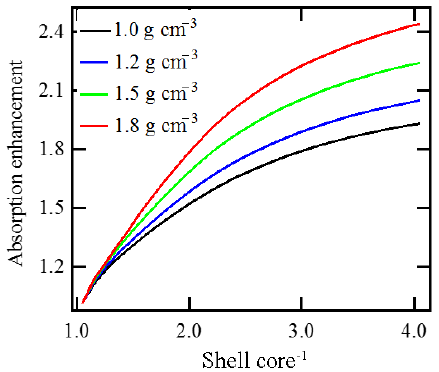
Figure 7. Changes in the absorption enhancement ( E ab ) at 550nm as the shell / core ratios ( D p /D c ) vary for size-resolved ambient In-BC particles (250nm) with different core